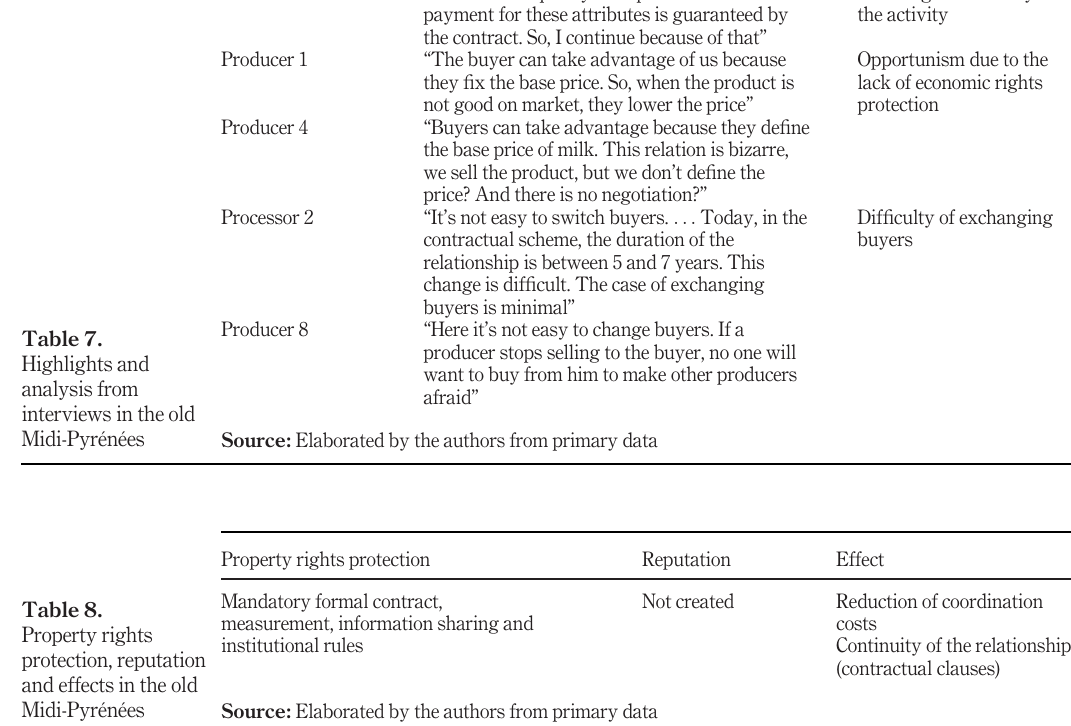
protection, reputation and effects in the old